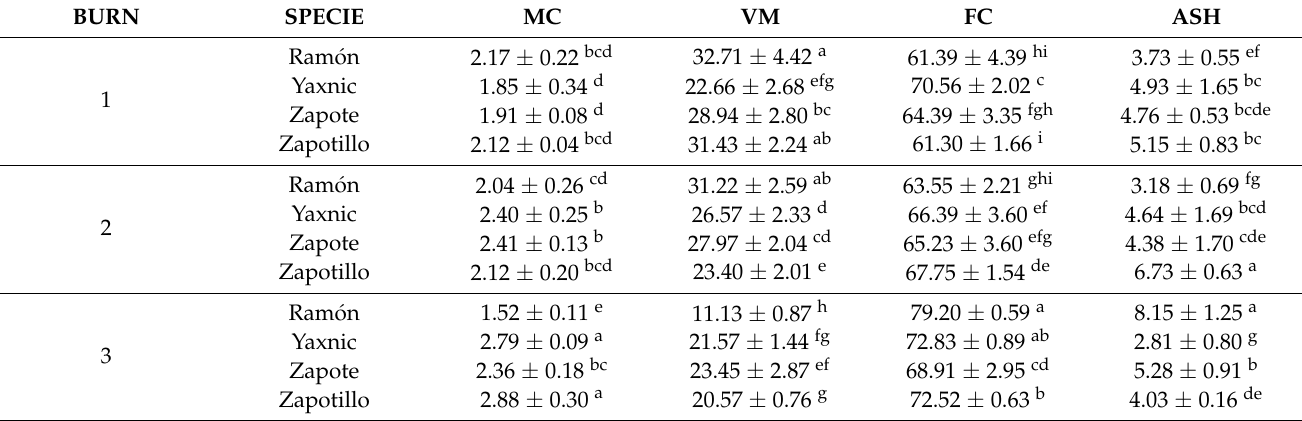
Table 10. Proximate analysis of charcoal produced in industrial metal kilns.